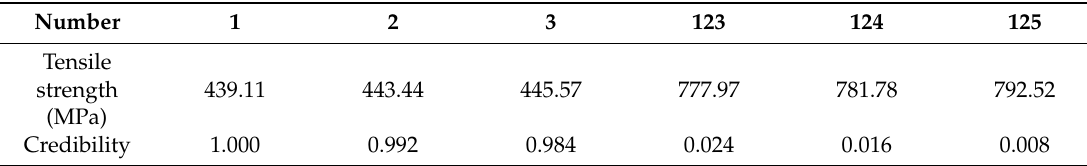
Table 2. Values of ultimate tensile strength and credibility obtained by means of the blind numbers